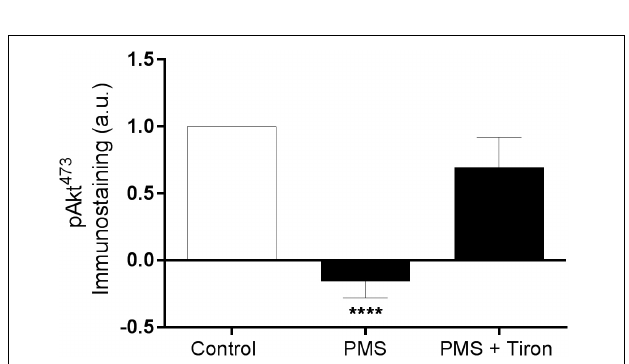
FIGURE 2 | Relative density of immunostained RBC treated with primary antibody against phosphorylated RBC-NOS Ser 1177 ; RBC incubated with the phenazine methosulfate (PMS) and the addition of a superoxide scavenger (Tiron) are reported as relative changes compared with Control RBC. ∗∗∗∗ p < 0.0001 significantly different compared with Control, ∗ p < 0.05 significantly different compared with Control. Error bars absent for Control, due to relative measurement.